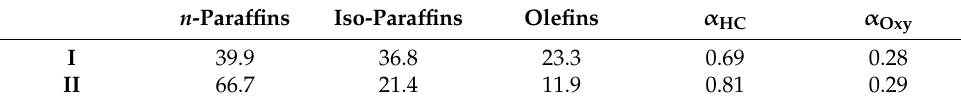
Table 5. Product composition of FTS at optimal synthesis